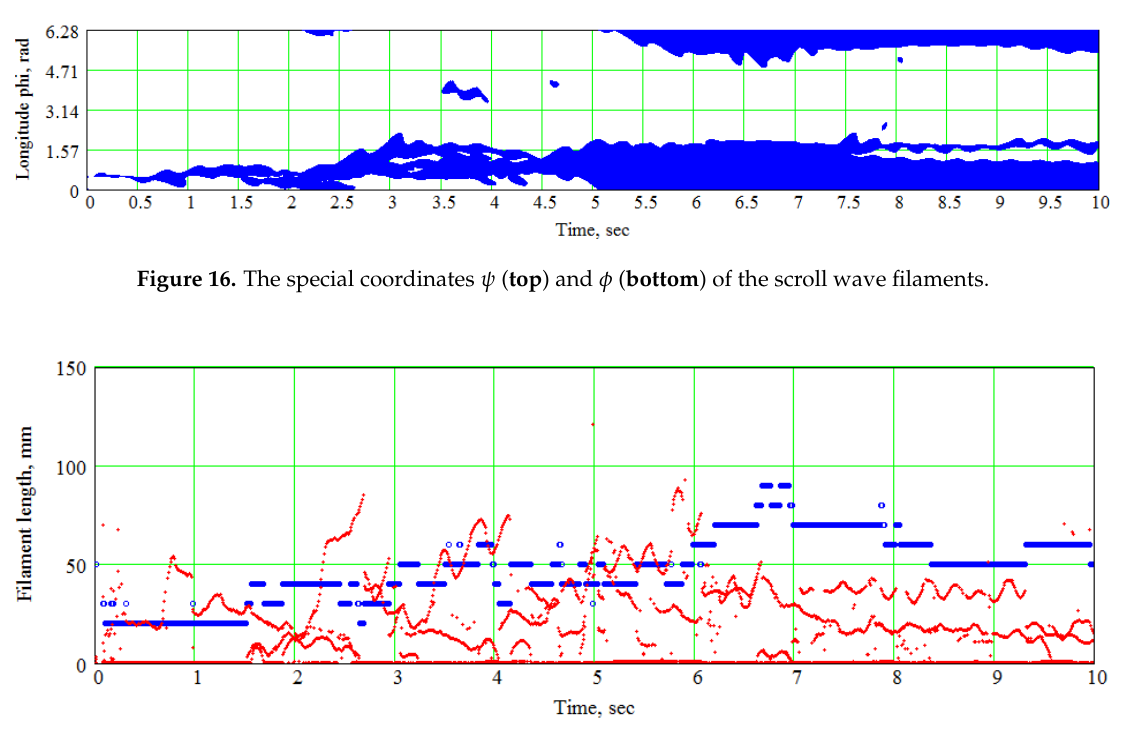
Figure 17. The number of filaments ( × 10; blue circles) and their lengths (red